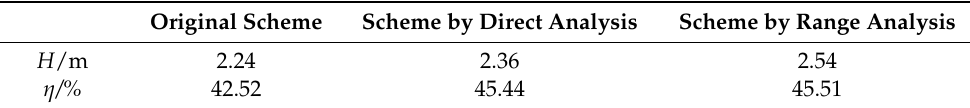
Figure 10. Hydraulic performance of the new type of dishwasher pump before and after optimization.